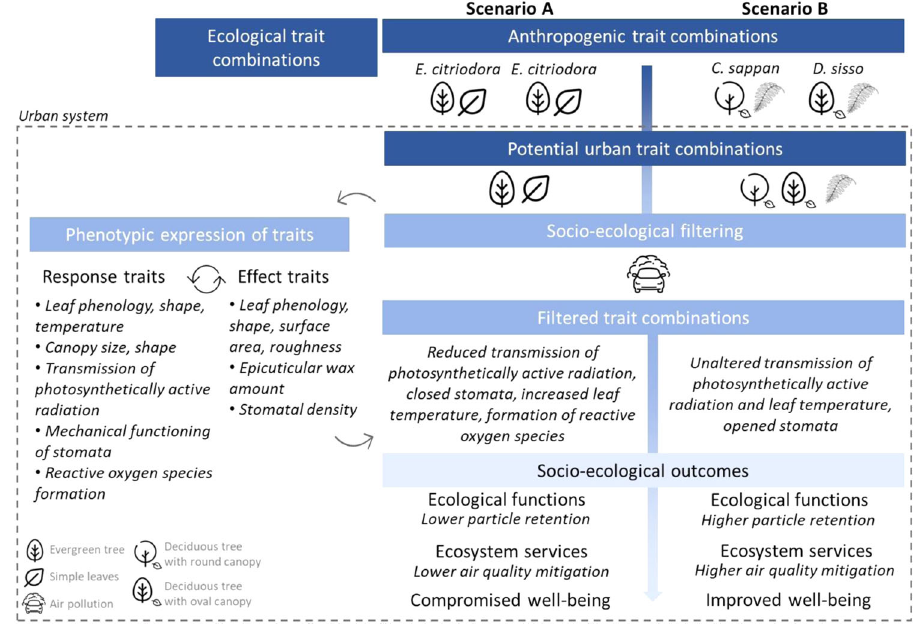
Fig. 3 Theoretical application of the Socio-Ecological Traits Framework. Scenarios A and B represent the same ecological trait combinations and different anthropogenic trait combinations. In scenario A, the anthropogenic trait combinations are composed of the traits of Eucaliptus citriodora — an evergreen tree with an oval canopy and simple leaves. In scenario B, the anthropogenic trait combinations are composed of the traits of Caesalpinia sappan — deciduous tree with round canopy and compound bipinnate leaves — and Dalbergia sisso — deciduous tree with oval canopy and compound bipinnate leaves. Therefore, both scenarios have different potential urban trait combinations, which are then affected by the same ecological fi lter of abiotic dimensions — high levels of air pollutants. This fi lter will affect the phenotypic expression of traits which will lead to contrasting resulting fi ltered trait combinations at the local scale, with consequences on ecological functions, ecosystem services, and human